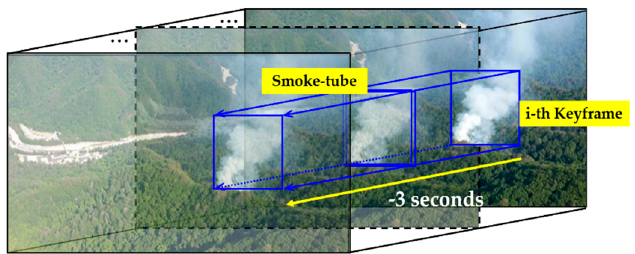
Figure 3. Smoke-tube configuration by considering the 30 frames for the previous 3 s based on the region detected in the current key frame. region detected in the current key